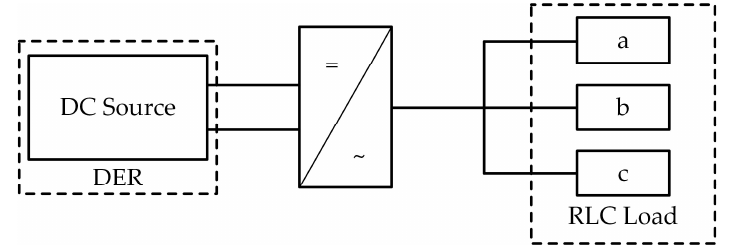
Figure 1. The microgrid tested in this paper. controller configuration is illustrated in Figure 2.